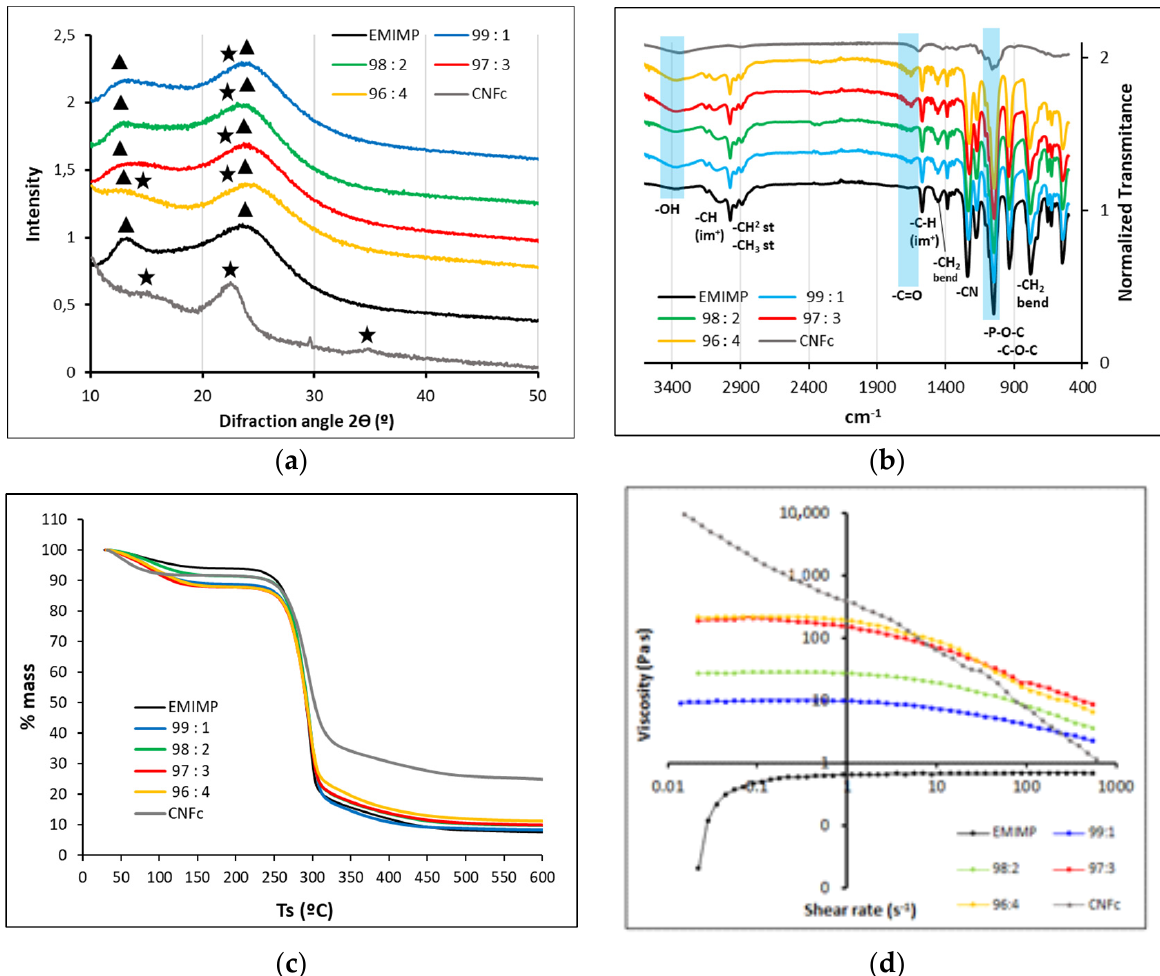
Figure 3. ( a ) XRD; ( b ) FTIR; ( c ) TGA and ( d ) Rheological data from CNFc-EMIMP GPE, including pristine CNFc (gel form at 1%wt) and